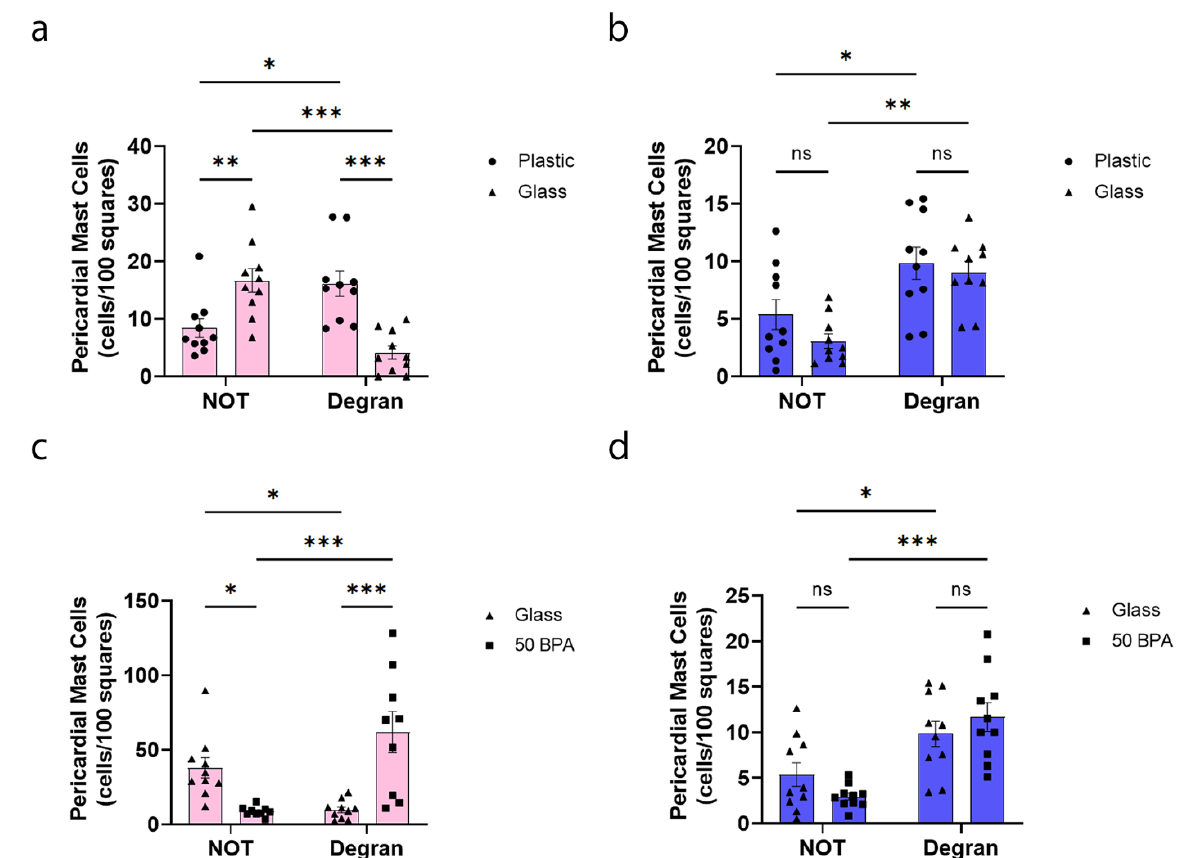
Figure 9. Plastic caging associated with pericardial mast cell degranulation in females, but not in males, where mast cells degranulate regardless of plastic exposure. ( a , c ) Female (pink) and ( b , d ) male (blue) BALB/c mice were given ( a , b ) normal drinking water (drinking water that did not contain BPA) for 2 weeks and housed either in glass cages/water bottles (glass) or plastic cages/water bottles (plastic) with soy-free food and bedding. ( c , d ) BALB/c mice housed in glass cages/water bottles with soy-free food and bedding were given either normal drinking water (drinking water that did not contain BPA) (glass) or 250 μ g BPA/L water (50 BPA) in glass cages for 2 weeks. Mice were injected i.p. with 10 3 PFU of CVB3 on day 0 and harvested at day 10 pi. Mast cell scoring was completed using the 40× high-power objective on a compound microscope. Mast cells were counted and categorized according to whether they were degranulated or not and by their location as pericardial. Data shown as scatter plot and mean +/−SEM using a Student’s t -test with 9 – 10 mice/group (* p < 0.05), (** p < 0.01), (*** p < 0.001).